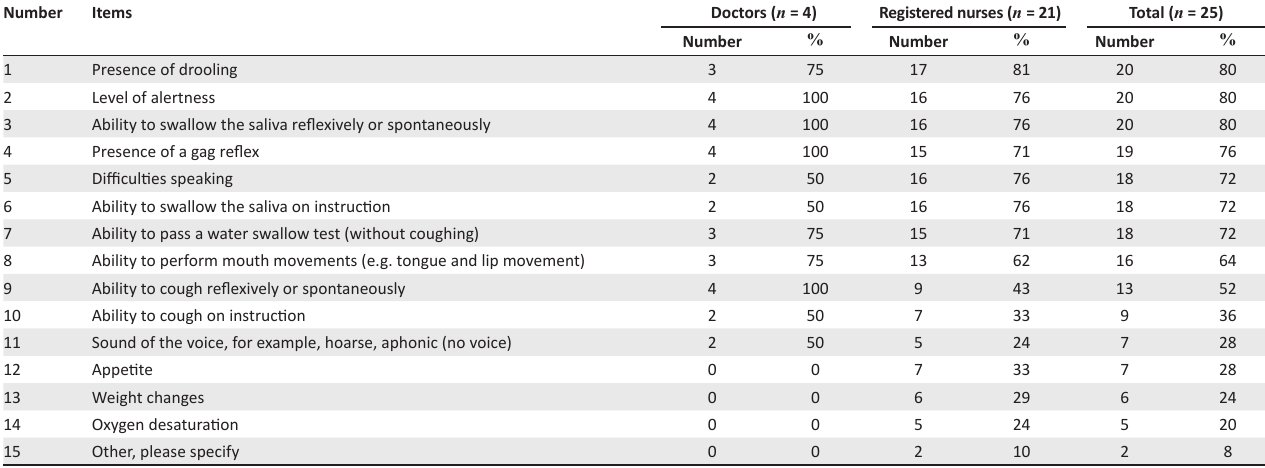
TABLE 2: Items screened to determine the presence of dysphagia.